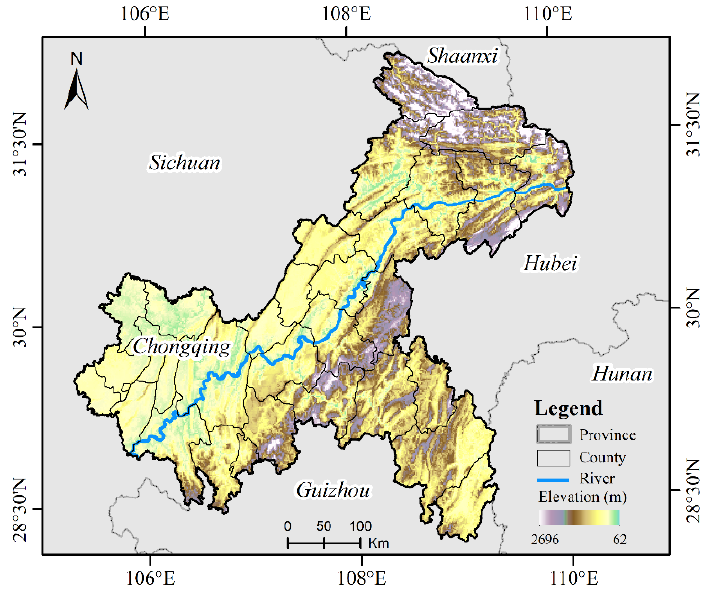
Figure 1. Map showing the geographic Location of Chongqing, China.